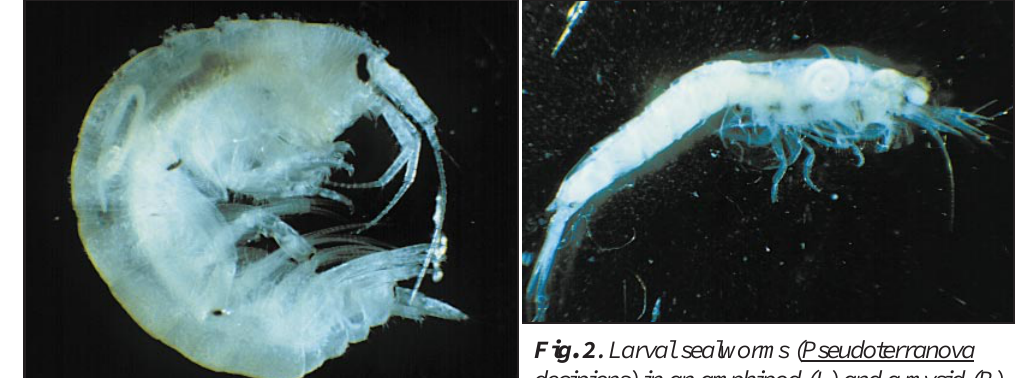
Fig. 2 . Larval sealworms (Pseudoterranova decipiens) in an amphipod (L) and a mysid (R).